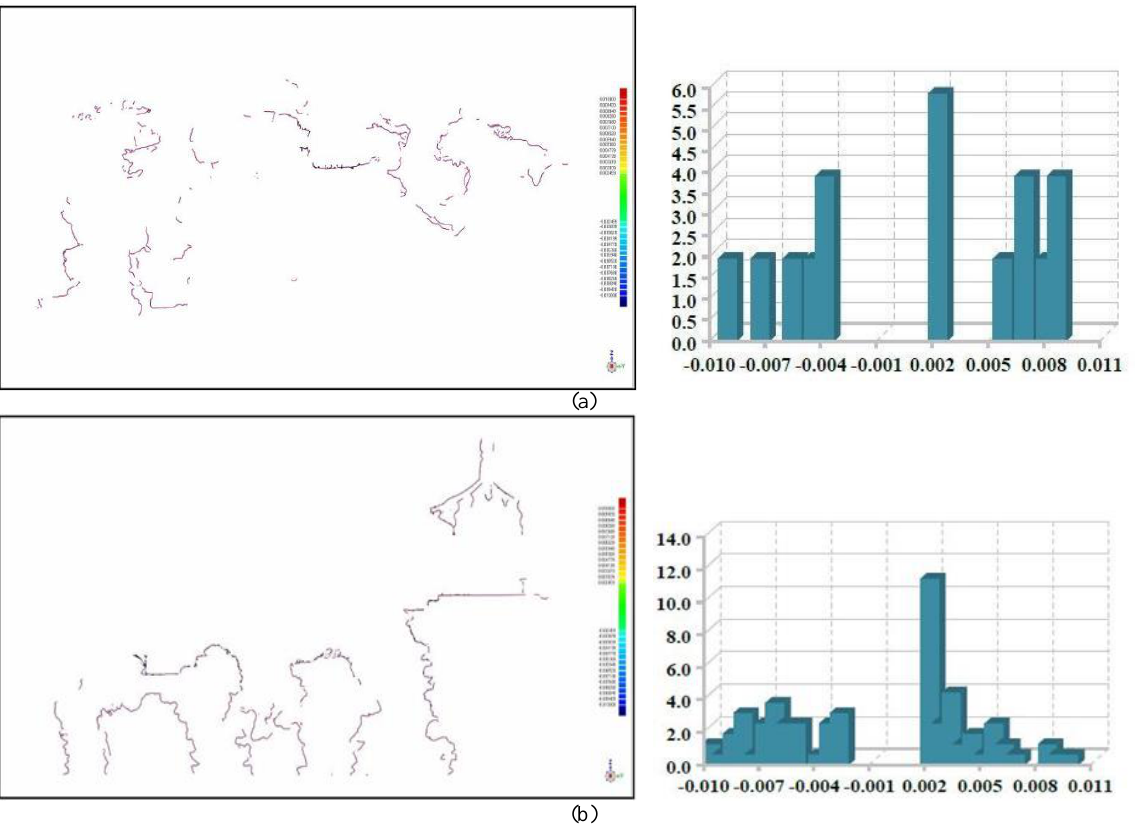
Figure 10. X= -3 and X=3 make the rockery profile and histogram; (a)Sectional view and histogram of X= -3(b)Sectional view and histogram of